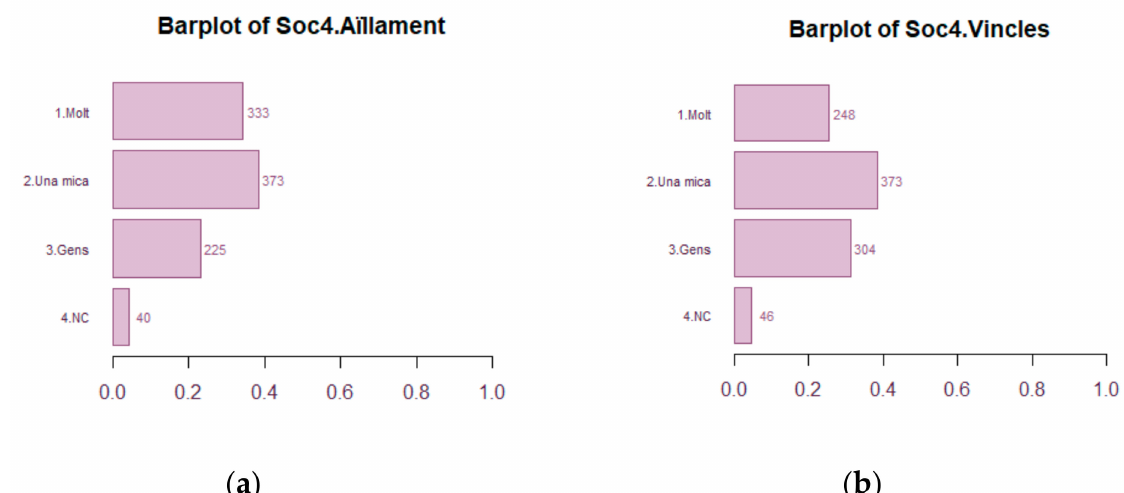
Figure 37. ( a ) Barplot of isolation feelings during pandemics ( b ) Barplot of intensification of links due to pandemics.